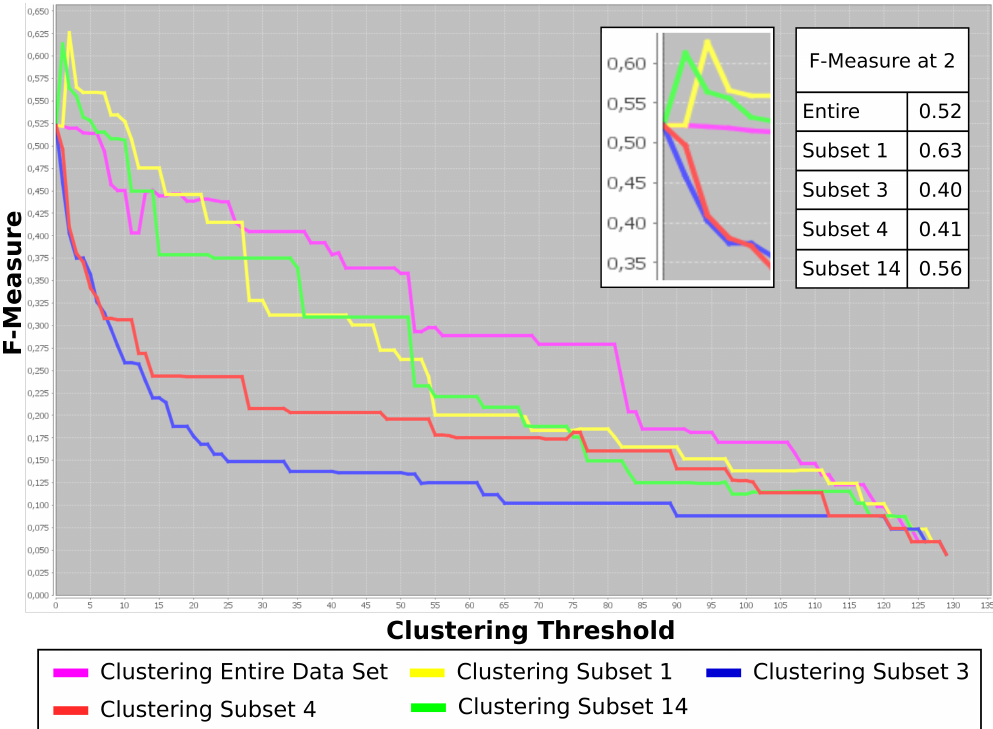
Figure 5. Comparison of the clustering results on the entire COPD dataset, i.e ., using all metabolites, as well as the four most interesting metabolite clusters (two best and two of the worst). The plot shows the F-measure for different clustering thresholds computed against the disease annotation (COPD, COPD with bronchial carcinoma (BC) and healthy). The Y-axis corresponds to the clustering threshold, in this case the number of splits. Given three groups of patients in the annotation, we are particularly interested in the performance at clustering results at T ∼ 2 (x-axis). This is shown in more detail in the zoomed cutout, as well as the table of F-measure values at this position. Two subsets of metabolites overlap with the patients’ disease annotation better than the clusterings based on the entire metabolite set. The two other metabolite subsets result in reduced F-measures, indicating a relation to confounding factors, in this case menthol (see the